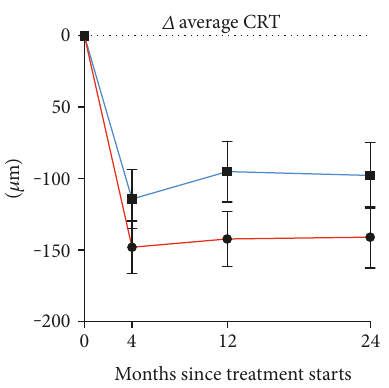
Figure 4: Change in average central retinal thickness of eyes with neovascular age-related macular degeneration in patients aged ≥ 90 years treated with either A fl ibercept (red) or Ranibizumab (blue). Dots and whiskers indicate mean and standard